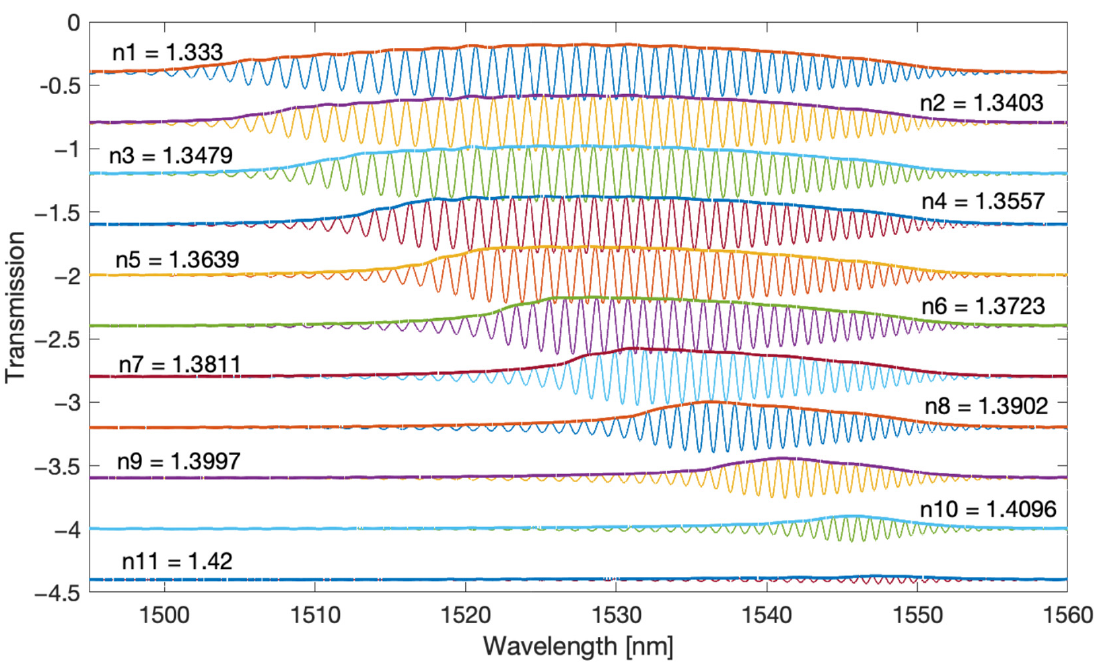
Figure 5. TFBG spectra after Fourier filtering for the second frequency band.